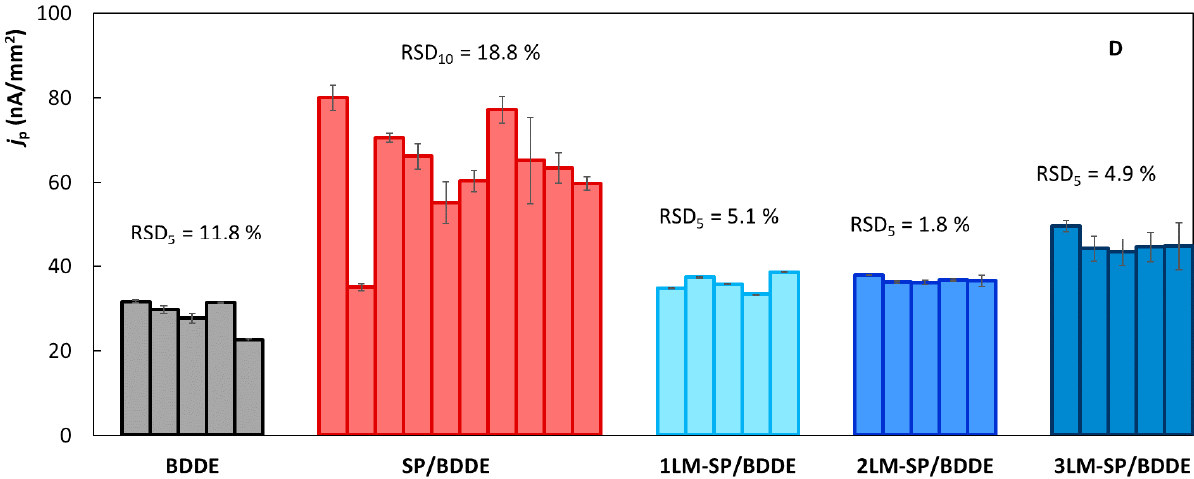
Figure 7. Repeated DP voltammograms of lornoxicam recorded on particular BDDEs ( A ), SP/BDDEs ( B ), and 2LM-SP/BDDEs ( C ); schematic illustration of intra- and inter-electrode repeatability of lornoxicam peak current densities ( D ) (DPV, electrolyte—BRB (pH 3), pulse amplitude = +60 mV, pulse width = 30 ms, v = 40 mV s − 1 , c (LRX) = 10 μ mol L − 1 ).